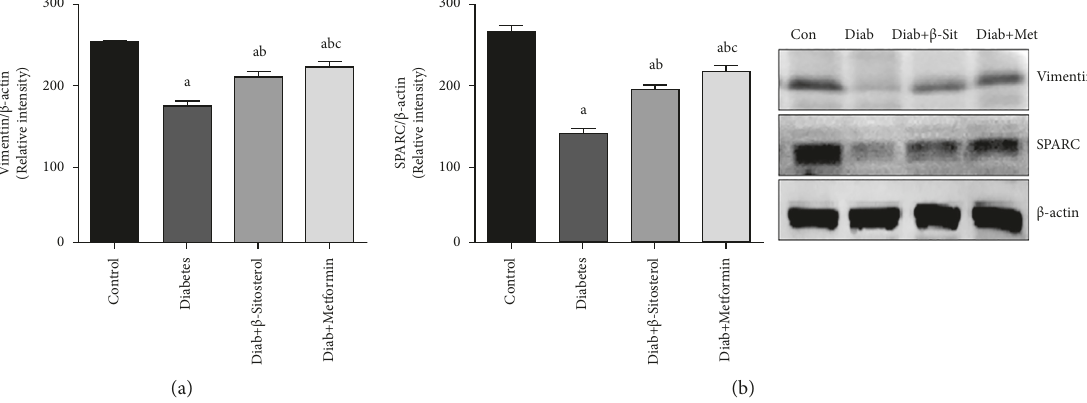
Figure 9: (a and b): Effect of β -sitosterol on vimentin and SPARC in diet-induced diabetic rats. The protein expression was checked by western blotting. β -actin was kept as a loading control. Mean ± SEM of 6 animals was represented in each bar. The values, which were statistically significant ( p < 0 . 05), were compared with a—control, b—diabetic control, and c— β -sitosterol-treated diabetic group. (a) Vimentin. (b)